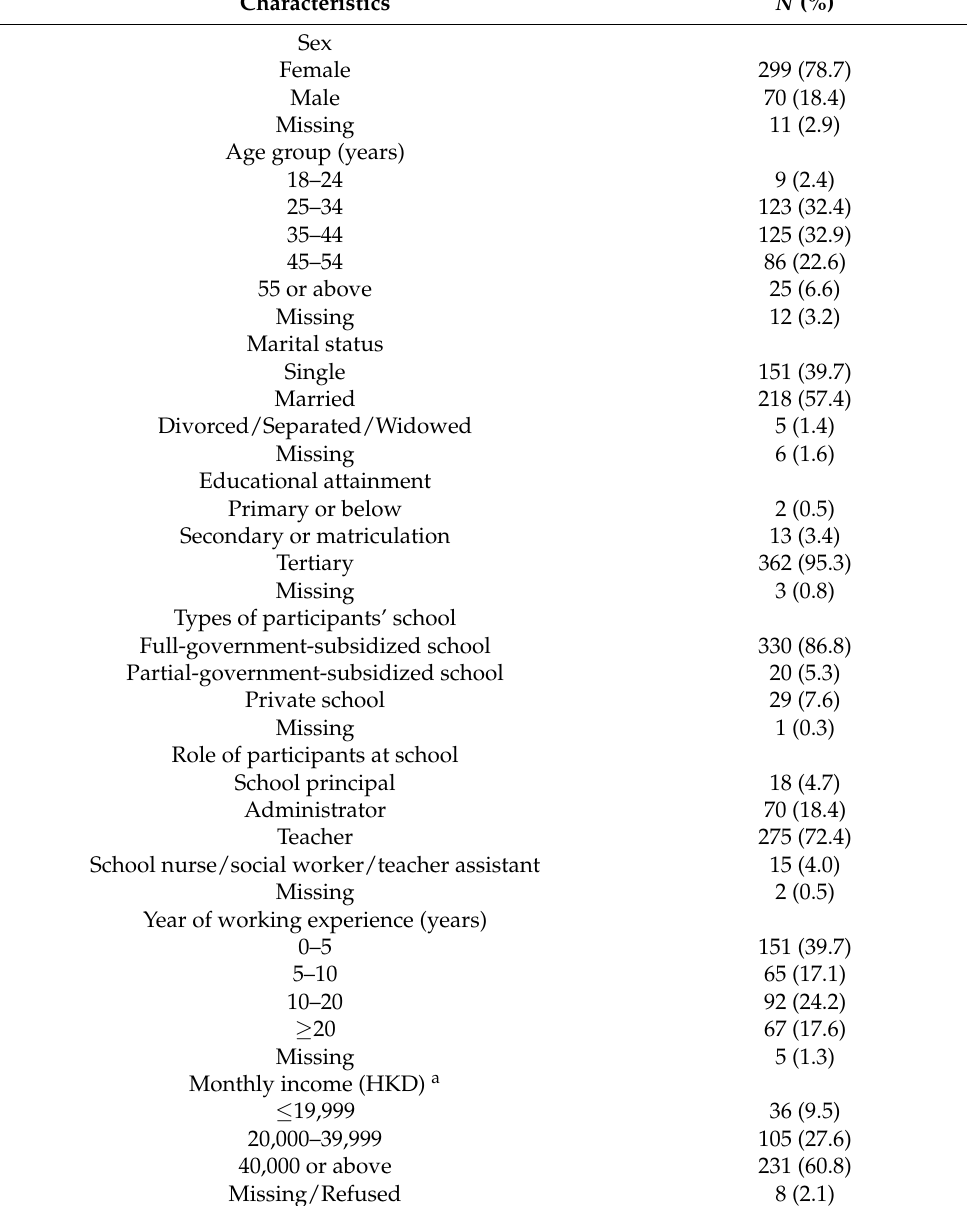
Table 1. Demographics of participants in the questionnaire survey ( N =